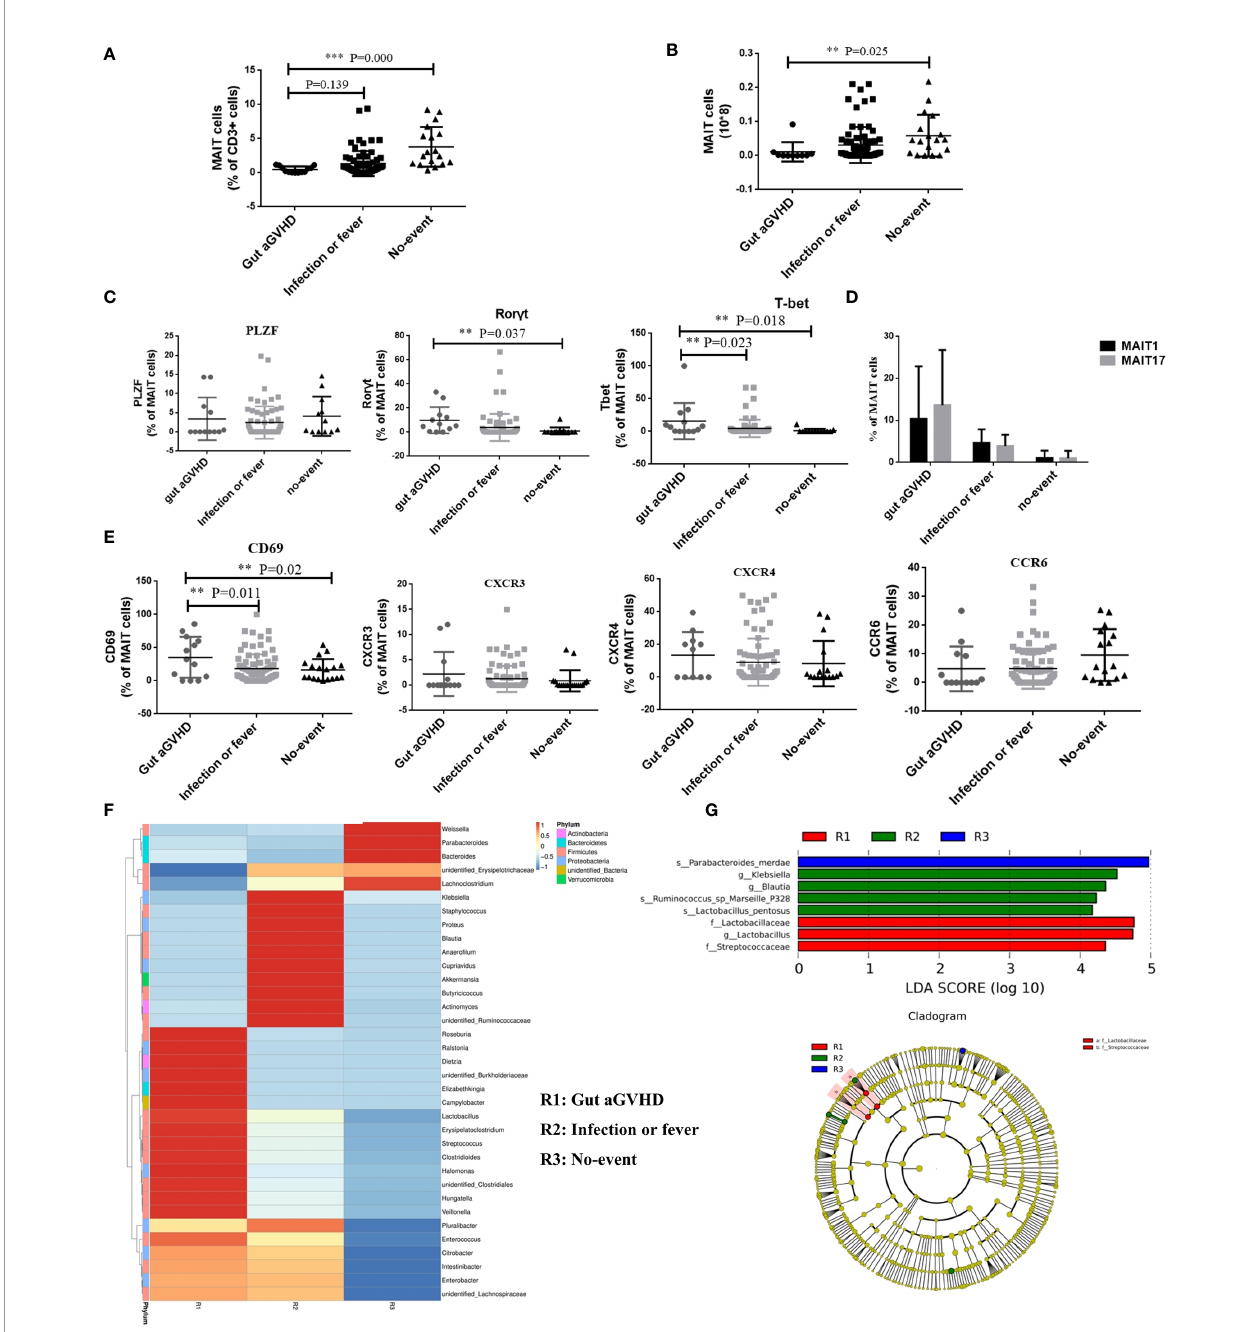
FIGURE 6 | The comparison of the number and function of mucosa-associated invariant T (MAIT) cells among patients with gut acute graft-versus-host disease (aGVHD) (n = 16), patients with infection or fever (n = 38) at the same time, and patients with no-event (n = 19) at the same time. (A) The comparison of the frequency of MAIT cells among gut aGVHD group, infection or fever group, and no-event group (Frequency: Gut aGVHD vs. No-event, p < 0.001). (B) The comparison of the number of MAIT cells among gut aGVHD group, infection or fever group, and no-event group (Number: Gut aGVHD vs. No-event, p = 0.025). (C) The comparison of T-bet+ MAIT (MAIT1) and Ror g t+ MAIT (MAIT17) among the three groups. (D) The comparison of the transcription factors among the three groups (Ror g t: Gut aGVHD vs. No- event, p = 0.037; T-bet: Gut aGVHD vs. No-event, p = 0.018; Gut aGVHD vs. Infection or fever, p = 0.023). (E) The comparison of the chemokine factors and markers among the three groups (Gut aGVHD vs. No-event, p = 0.02; Gut aGVHD vs. Infection or fever, p = 0.011). (F) Cluster heat map of species abundance at the genus level. (G) LDA score distribution histogram and cladogram. Levels of signi fi cances are given as p-values with *** ≤ 0.01 and ** ≤